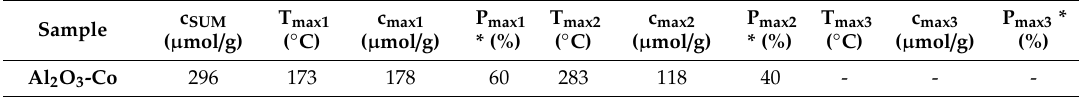
Table A2. Acidity of cobalt catalyst determined by ammonia TPD.